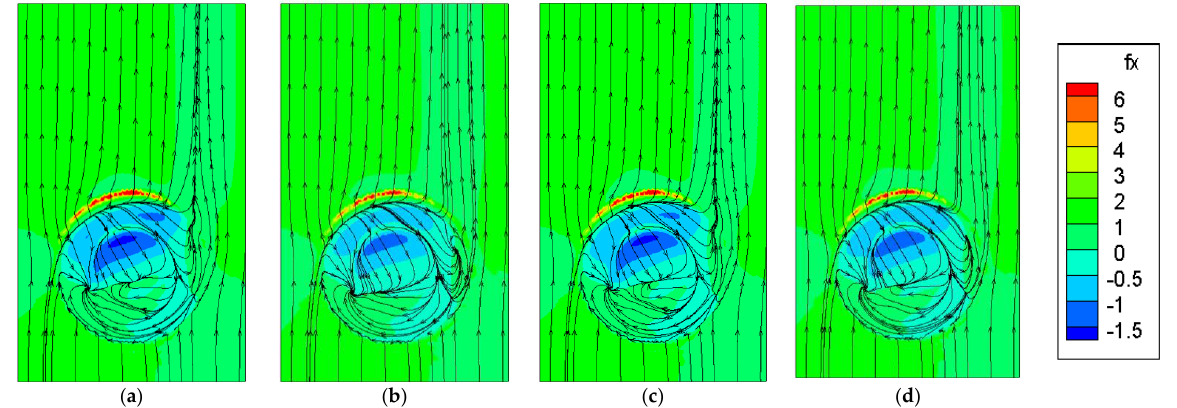
Figure 4. Calculated fields of the relative friction 𝑓𝑥/𝑓𝑥 𝑝𝑙 and the source streamlines in the control area of the channel walls with the dimples of different standard SST models and the modified Menter SST models: ( a ) Menter 1993 SST model, ( b ) Menter 2003 SST model, ( c ) Menter SST model corrected according to RLI, and ( d ) Menter SST model corrected according to SM.